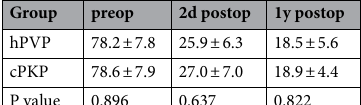
Table 3. The change of ODI (%) in the pre- and post-operative period.